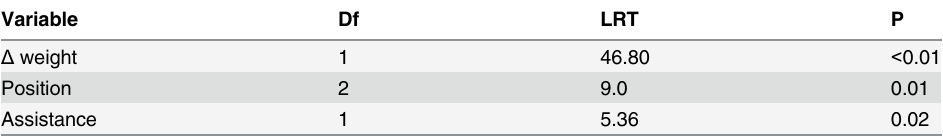
Table 4. Likelihood ratio test (LRT) of the minimum adequate model (M3) of the binary logistic regression.